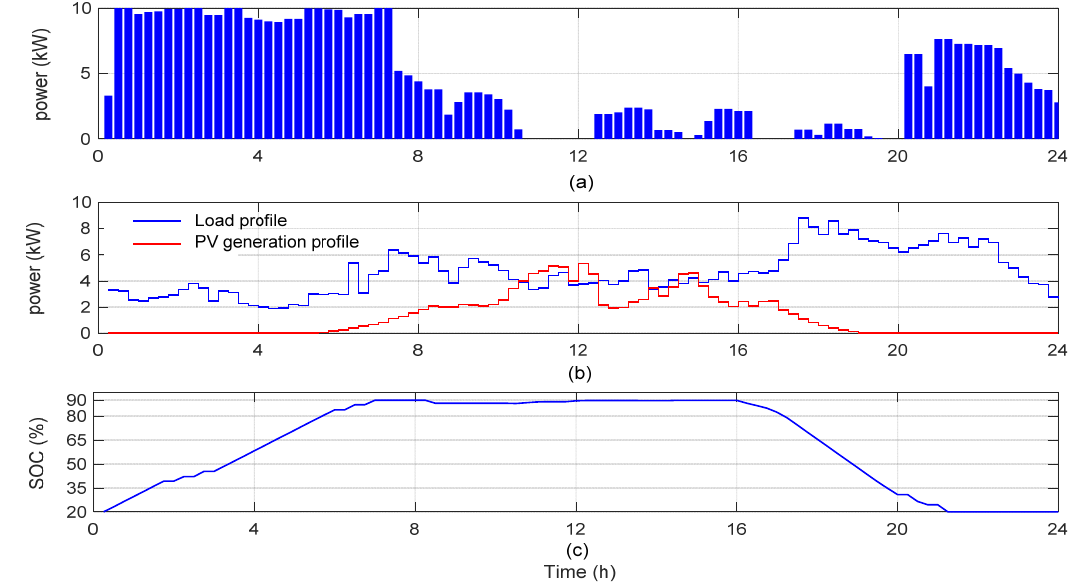
Figure 7. ( a ) Reference values for the power drawn by the MG from the main grid for spring; ( b ) MG’s forecasted load and PV generation profiles; ( c ) Resultant state of charge curve of the BESS.